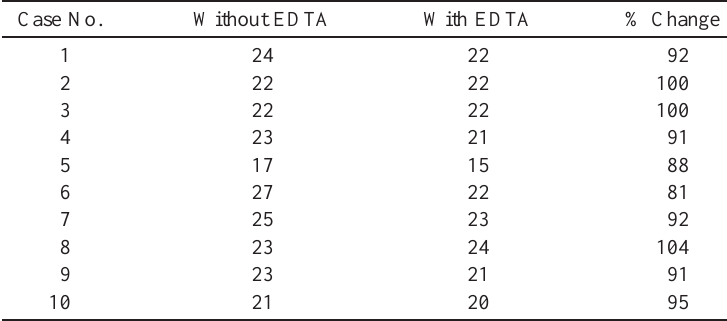
Table 4 Aggregated results of nuclear morphometry in bone marrow samples according